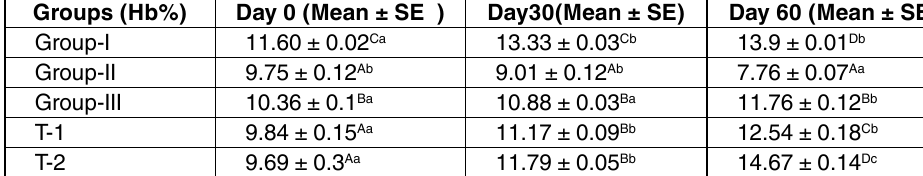
table 3. The mean ± SE haemoglobin (g/dl) values in different treatment groups. Groups